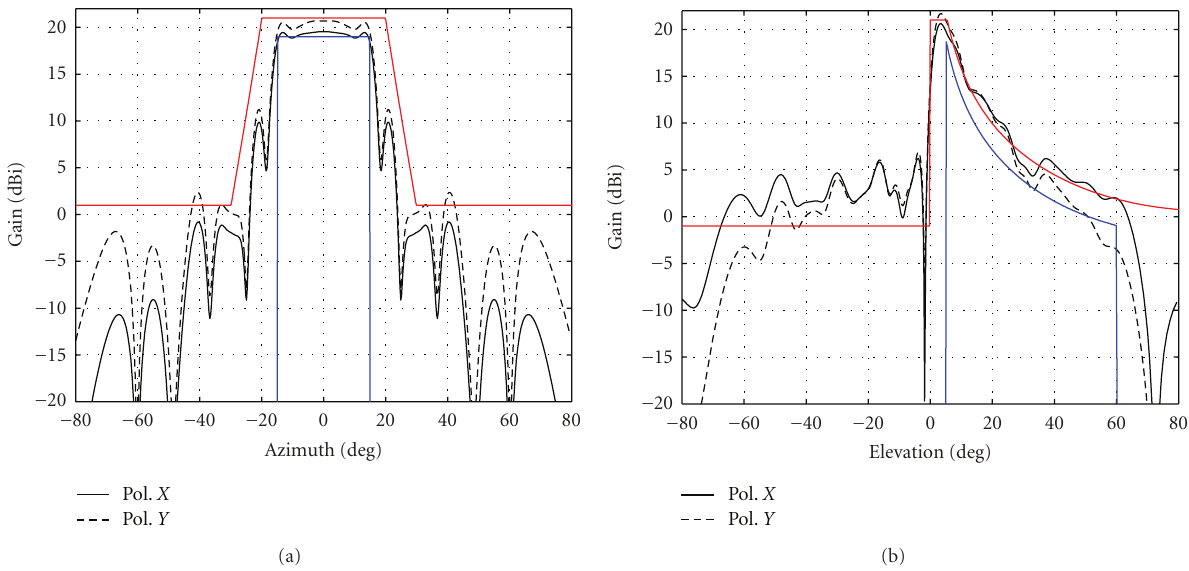
Figure 6: Simulations (vertical and horizontal polarizations) at the central frequency. Main cuts in azimuth (a) and elevation (b), compared with the maximum and minimum required gains (solid red and blue